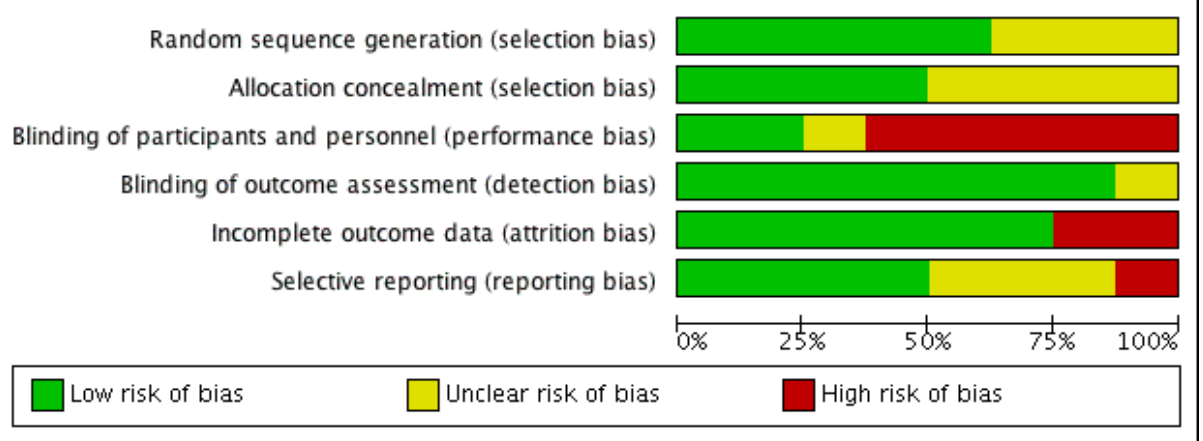
Figure 3. Risk of bias graph: review authors' judgements about each risk of bias item presented as percentages across all included studies.